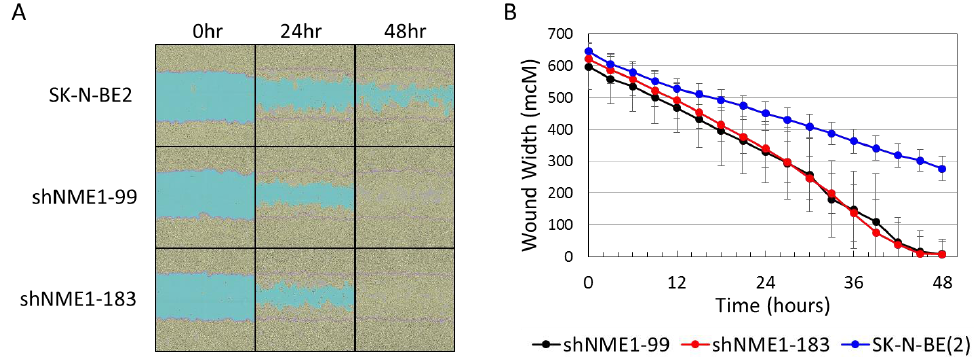
Figure 5. NME1 depletion affects neuroblastoma cell migration. ( A ) Control SK-N-BE(2) neuroblastoma cells and cells with depleted NME1 (shNME1-99, shNME1-183) were plated and analyzed for migration into a scratch wound using continuous live cell imaging. Images were taken every six hours and wound width was measured at each time point. Representative images ( A ) and a graph of relative wound width over time ( B ) are shown. Respective p values of depleted NME1 with shNME1-99 (black) and shNME1-183 (red) to control SK-N-BE(2) (blue) were 1.3e-2 and 2.6e-2.